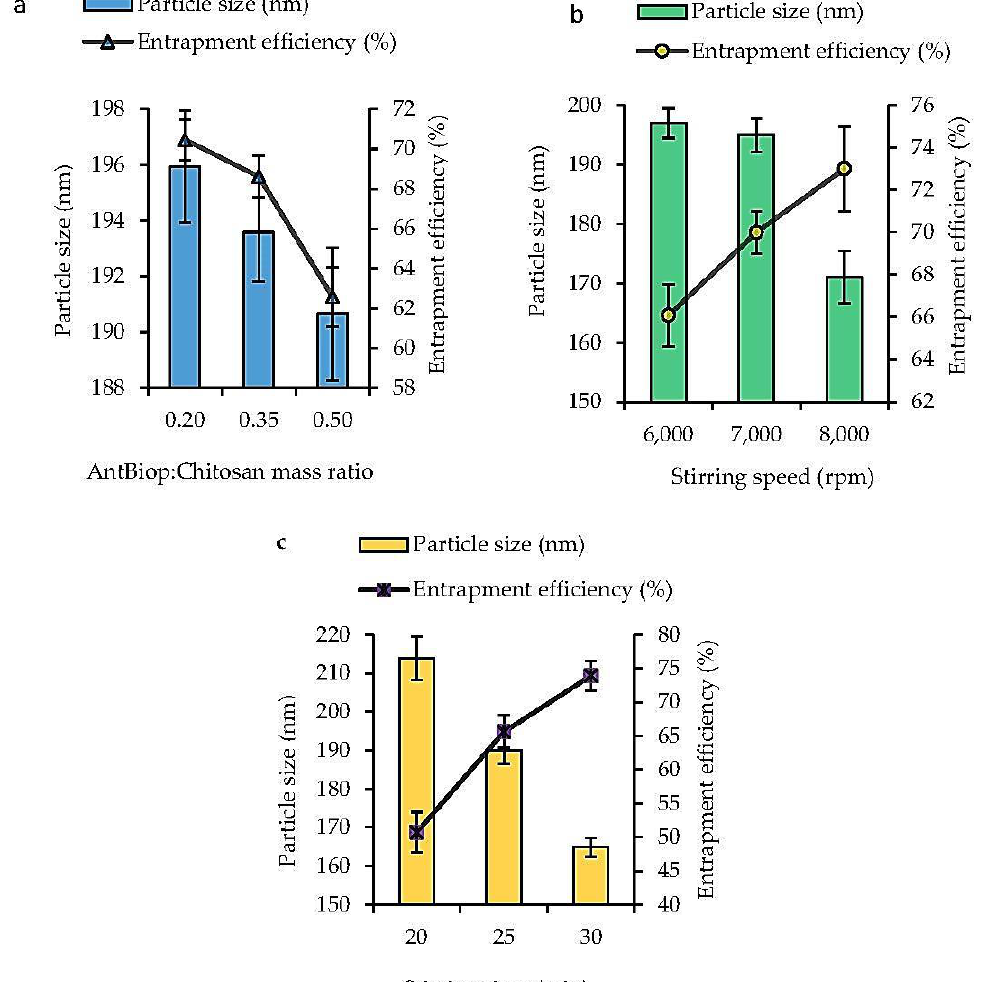
Figure 1. Effect of formulation parameters on the particle size (nm) and entrapment efficiency (EE, %) of Chit-AntBiop-NPs ( a ) AntBiop:Chitosan mass ratio; ( b ) stirring speed; ( c ) and stirring time.